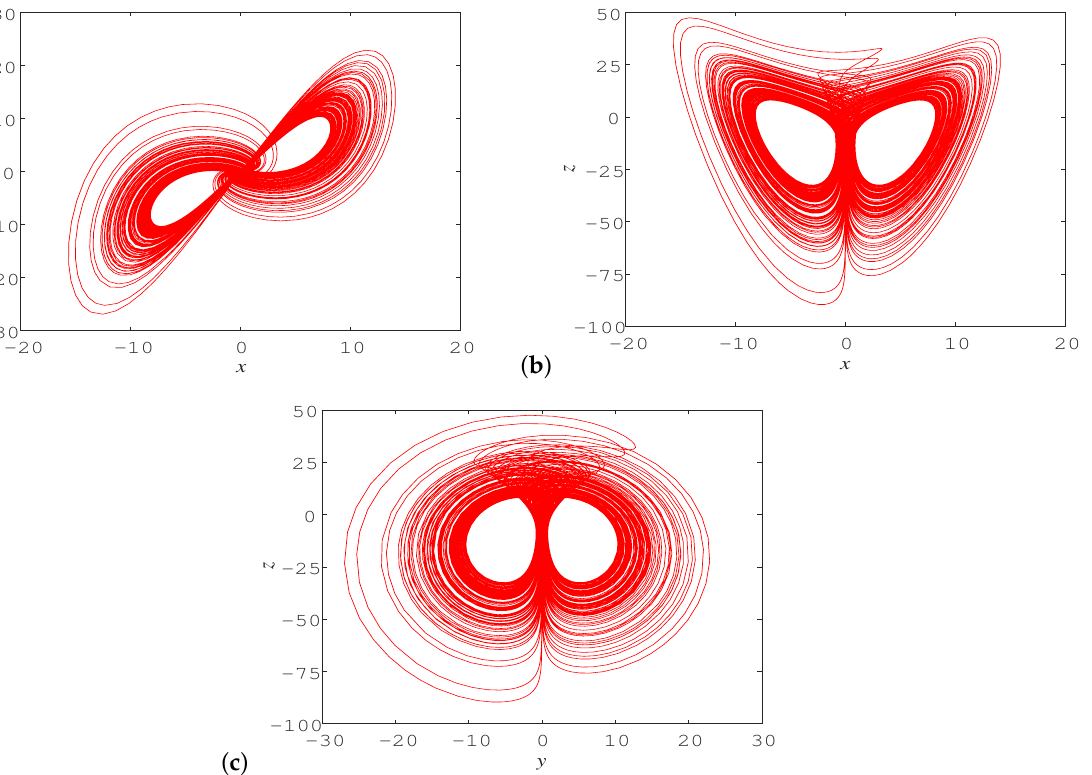
Figure 3. Projection in different two-dimensional (2D) phase spaces of system (2) for ( a , b , c , k ) = ( 12,100,10,4.6 ) : ( a ) x - y plane, ( b ) x - z plane, and ( c ) y - z